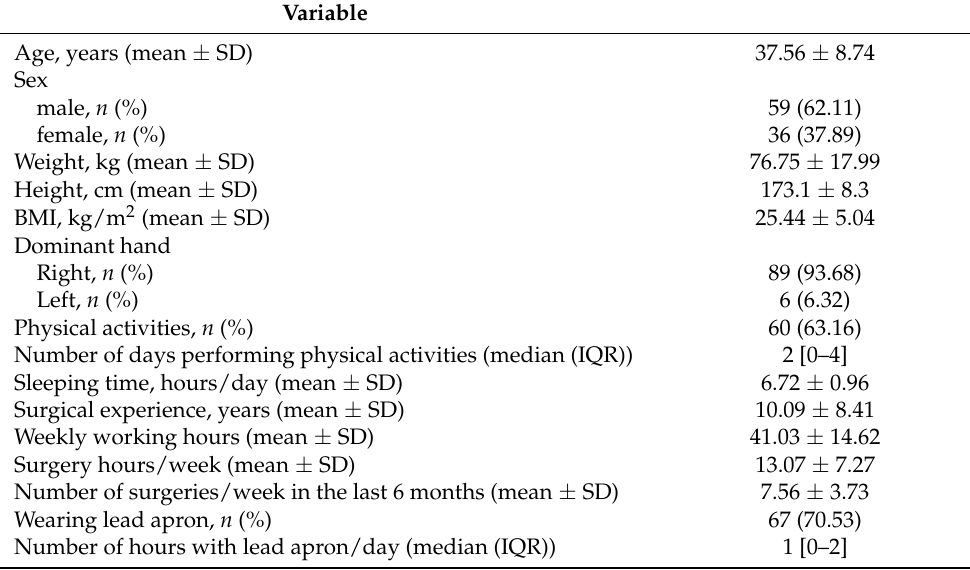
Table 1. Participants’